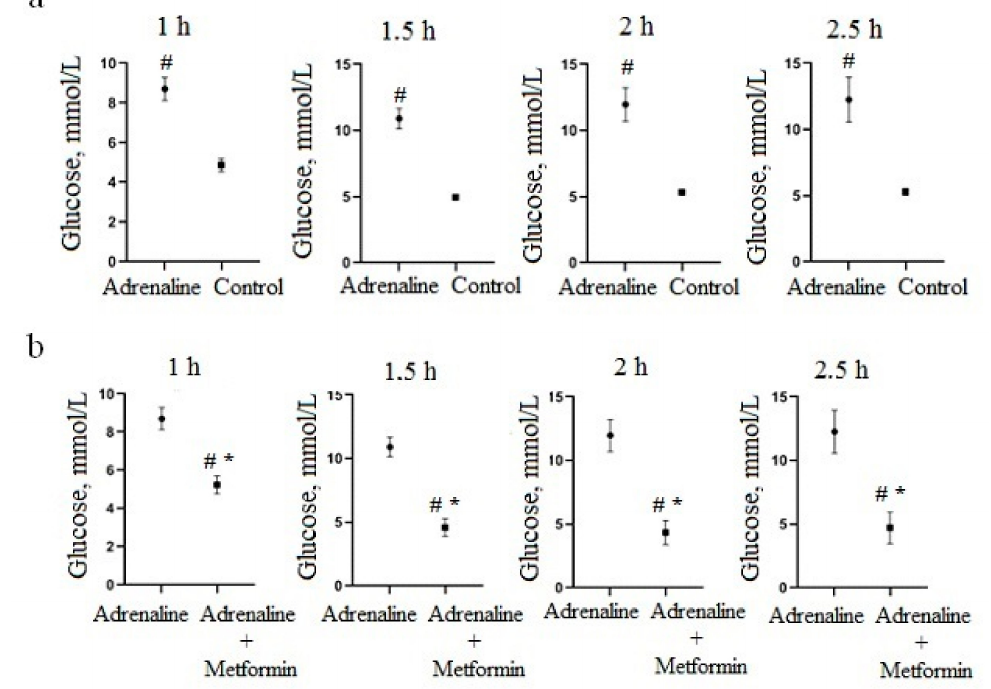
Figure 2. Change in glucose level in blood after administration of a peritoneal adrenaline hydrochlo- ride solution at a dose of 1 mg/kg: ( a ) compared to a control group and ( b ) compared to group with oral pre-administration of metformin at a dose of 300 mg/kg. # Significantly different from the control group; * significantly different from the metformin